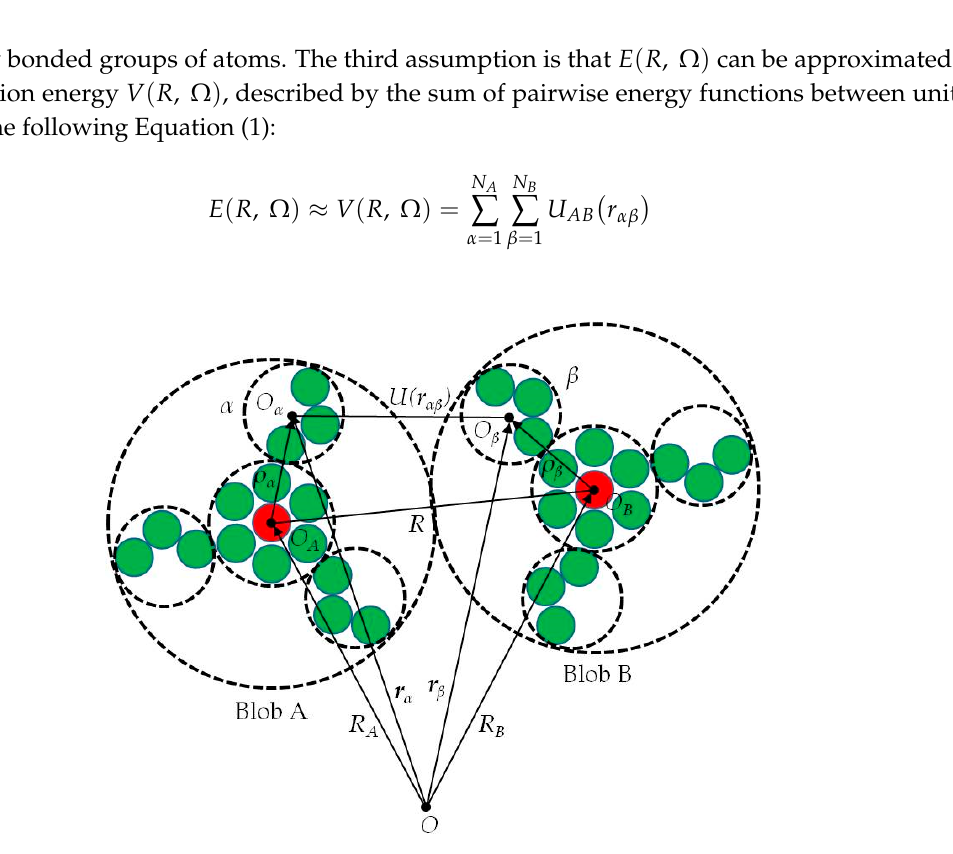
Figure 1. Schematic illustration of two blobs in a laboratory fixed coordinate system. Atoms are represented by small solid circles.